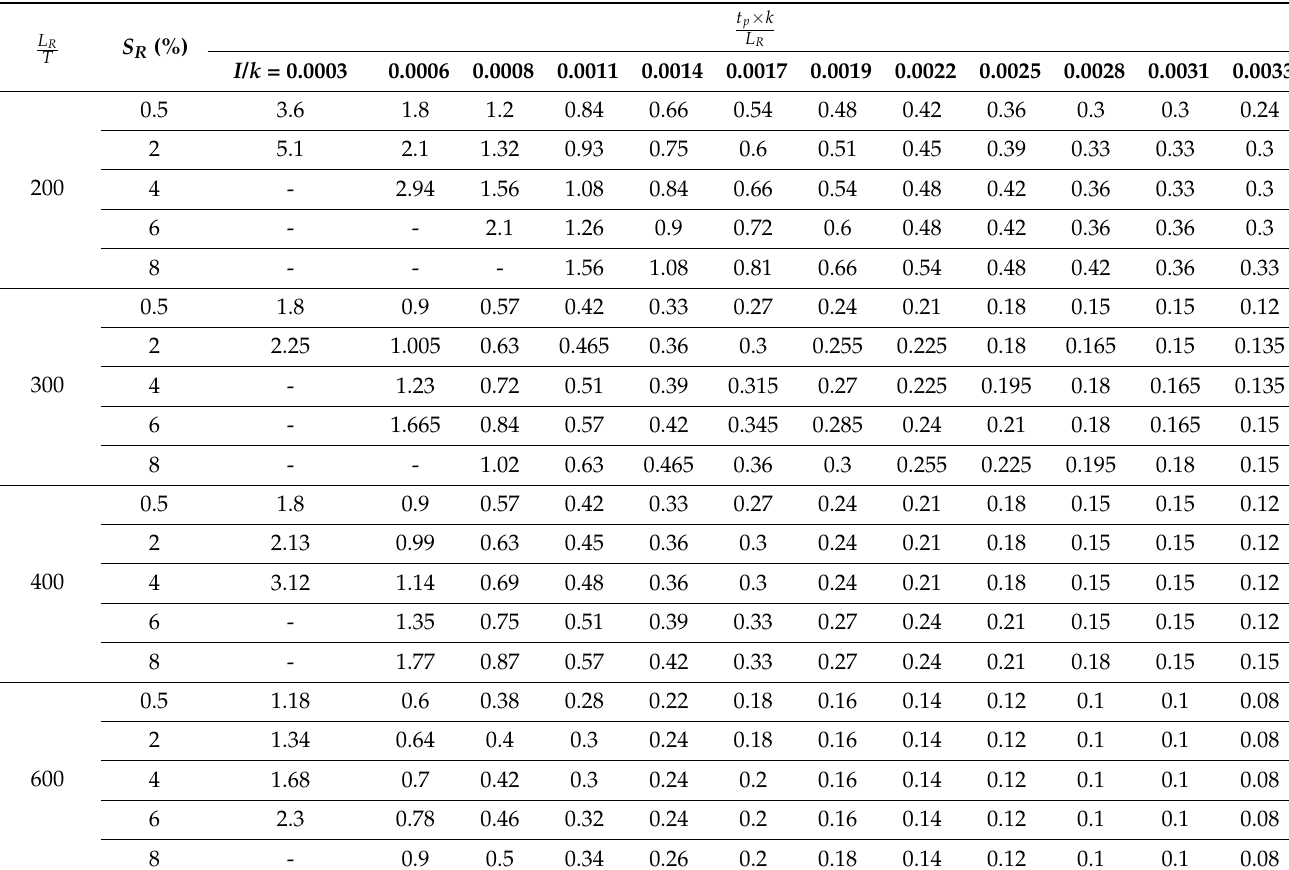
Table 7. Normalized variables for PFC pavement design.